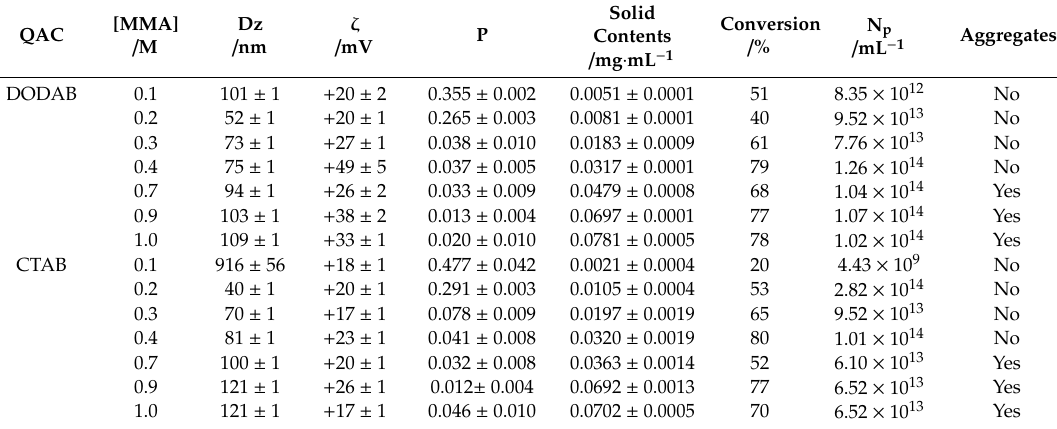
Table 2. Physical properties of PMMA / QAC NPs obtained by emulsion polymerization of MMA monomer over a range of [MMA] at 2 mM DODAB or CTAB using AIBN as the initiator. Zeta-average diameter (Dz), zeta potential ( ζ ), and polydispersity (P) were obtained by dynamic light scattering. The conversion of monomer into polymer was expressed in percentile. The particles’ number density (N p ), in mL − 1 , was calculated from nanoparticle size (Dz) and the mass of lyophilized dispersions. Solid contents, conversion, and N p were determined as previously described in